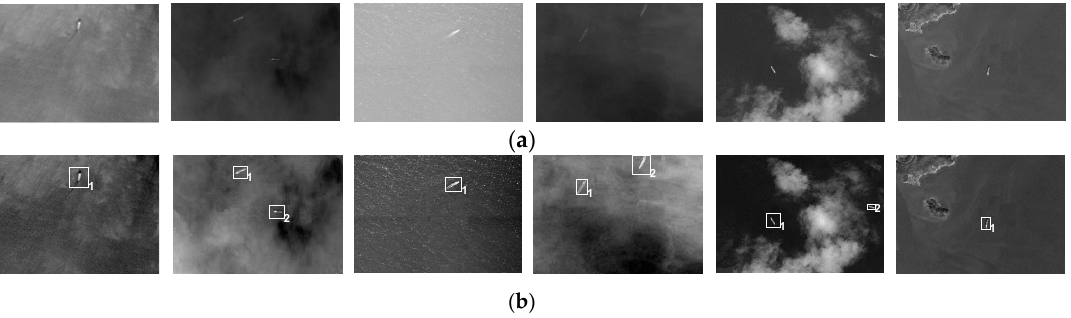
Figure15. Detection results after discrimination: ( a ) gray images; ( b ) synthetic images. Figure 15. Detection results after discrimination: ( a ) gray images; ( b ) synthetic